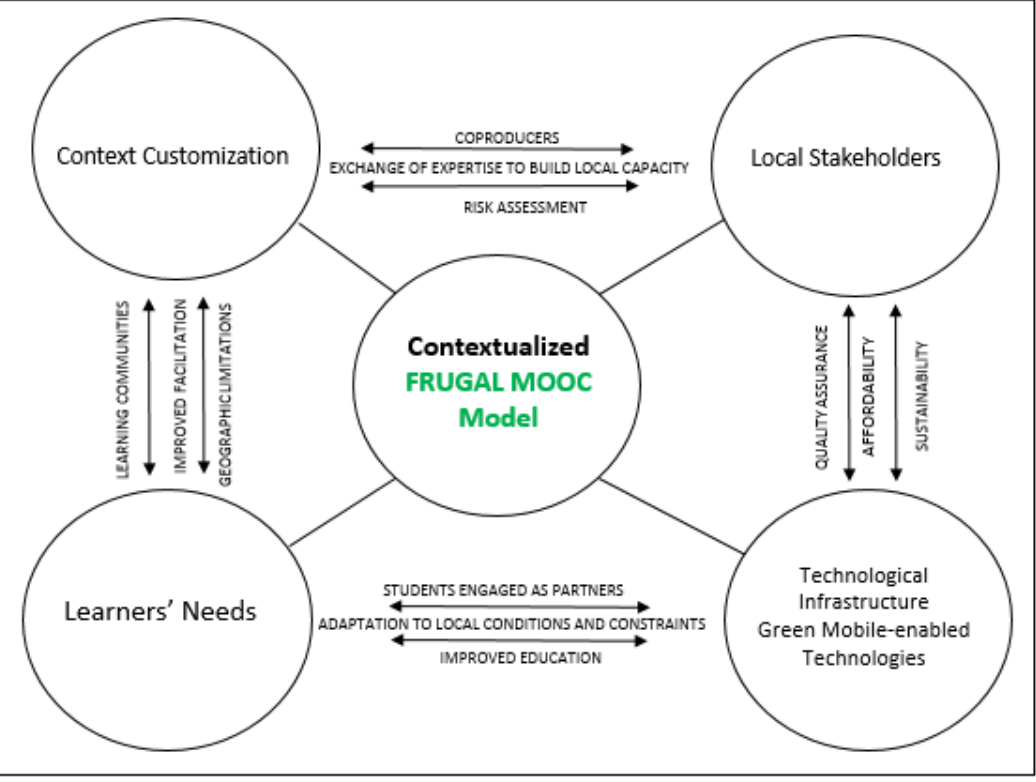
Figure 1. Frugal MOOC